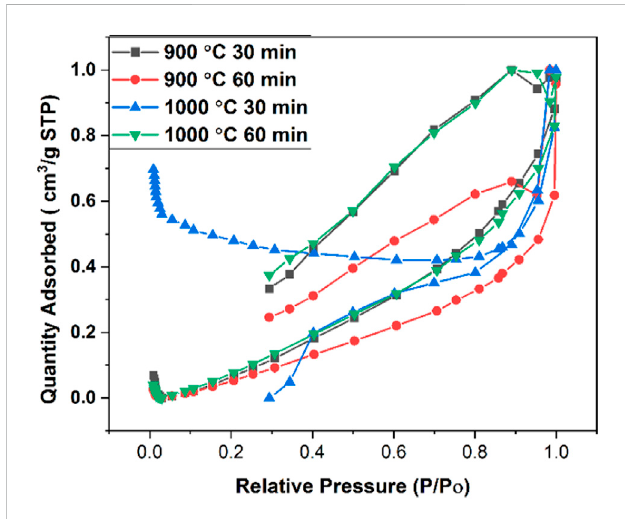
FIGURE 4 BET adsorption and desorption isotherm for calcined CFB.